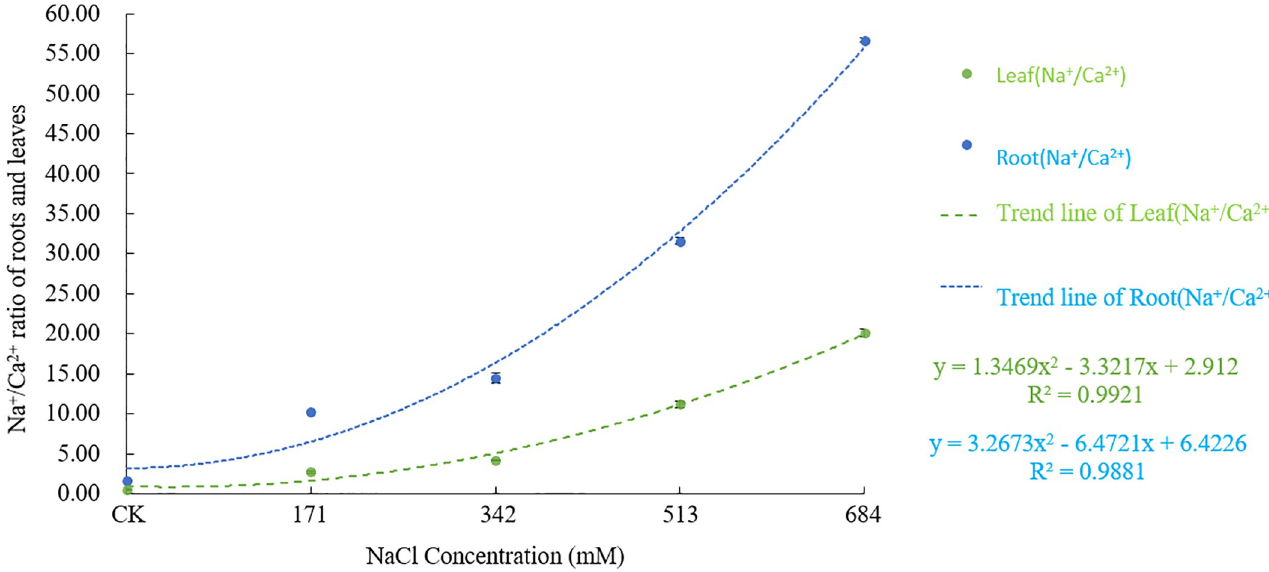
Fig 5. Effects of salt stress on Na + / Ca 2+ in roots and leaves of Salix alba L.